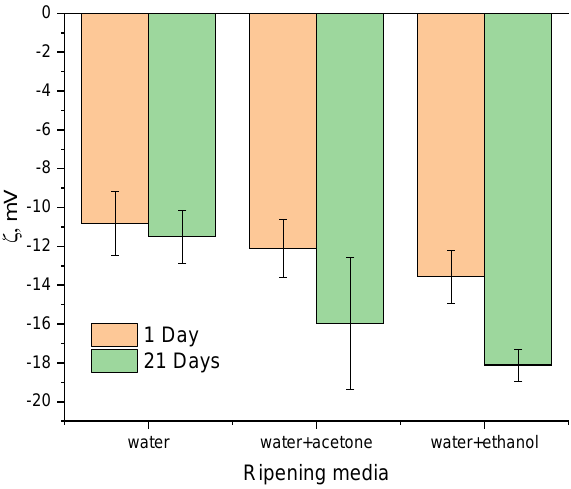
Figure 7. Zeta potential results of the as-synthesized powders and those data after 21 days of rip- ening.